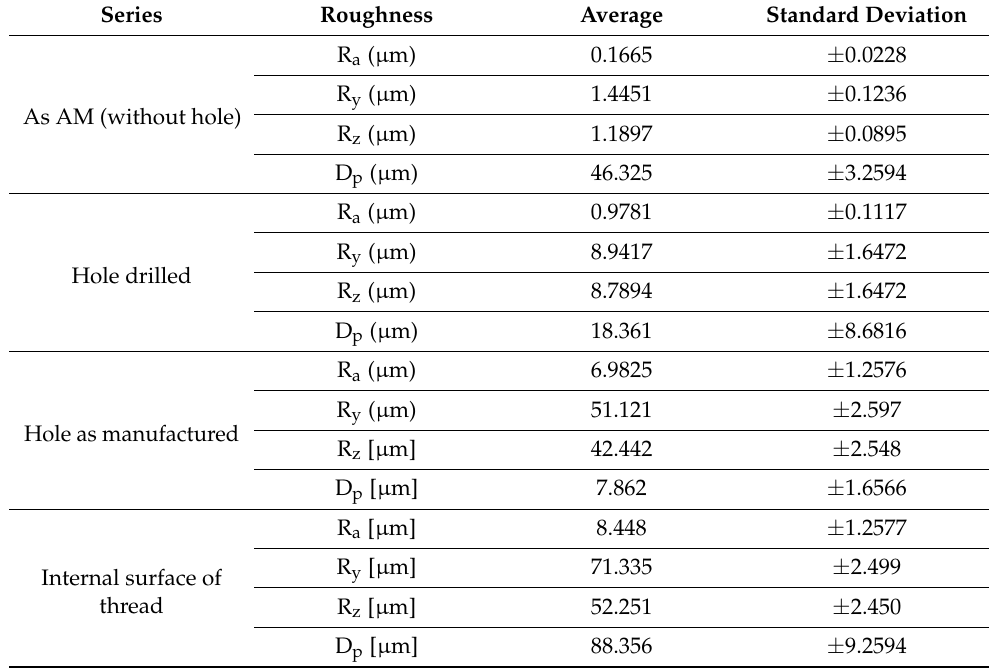
Table 2. Roughness parameters for each case.